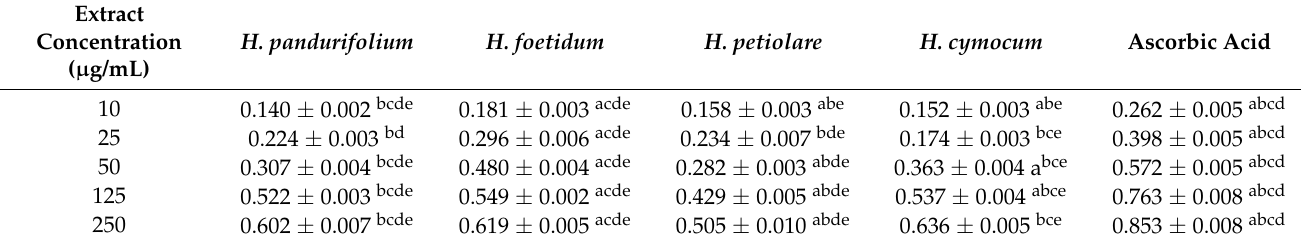
Table 3. Reducing power activity of aqueous acetone extracts of H. pandurifolium, H. foetidum H. petiolare, and H. cymocum .